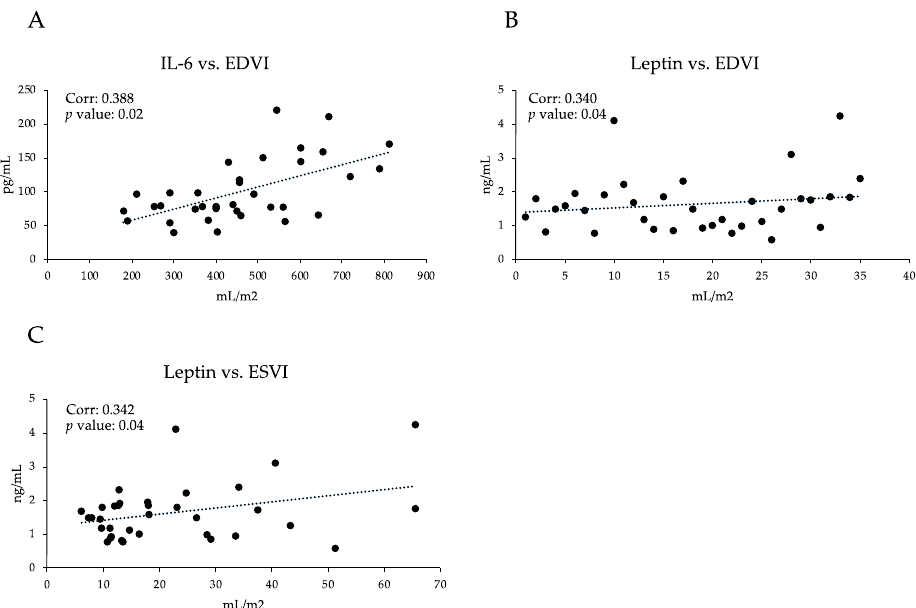
Figure 2. Pearson’s correlation. Leptin (ng/mL) vs. EDVI (mL/m 2 ) ( B ); Leptin vs. ESVI (mL/m 2 ) ( C ); and IL-6 (pg/mL) vs. EDVI ( A ) of the mild and moderate MMVD (B1–B2) group and the severe and very serious MMVD (C–D) group of dogs.